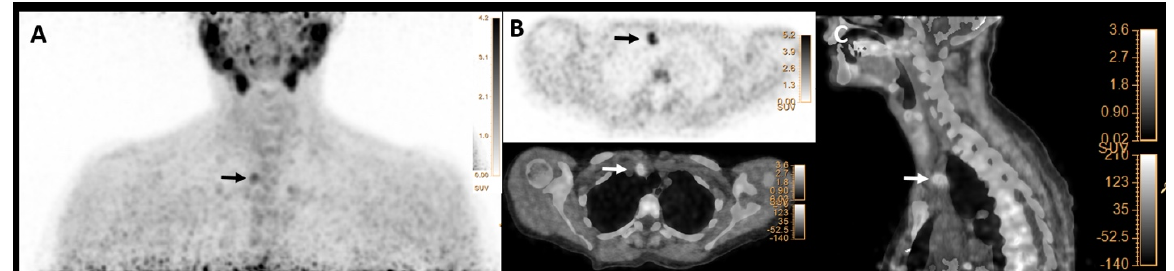
Figure 2. [ 18 F]FCH PET/CT images ( A – C ) in a 62-year-old woman with elevated serum PTH of 190 pg/mL (normal value = 16–65) and calcium level of 2.89 mmol/l (normal value = 2.13–2.63), respectively. ( A ) Maximum intensity projection (MIP) shows focal tracer uptake in the right upper mediastinum (arrow). ( B ) transaxial PET (upper row) and hybrid PET/CT (lower row) as well as ( C ) sagittal hybrid PET/CT images show focal tracer uptake in the right upper mediastinal region, lateral to the truncus brachiocephalicus with SUVmax of 5.2 and mSAD = 11mm, compatible with an ectopic parathyroid adenoma (arrows), that was found to be 20mm ectopic parathyroid adenoma on histopathology result.